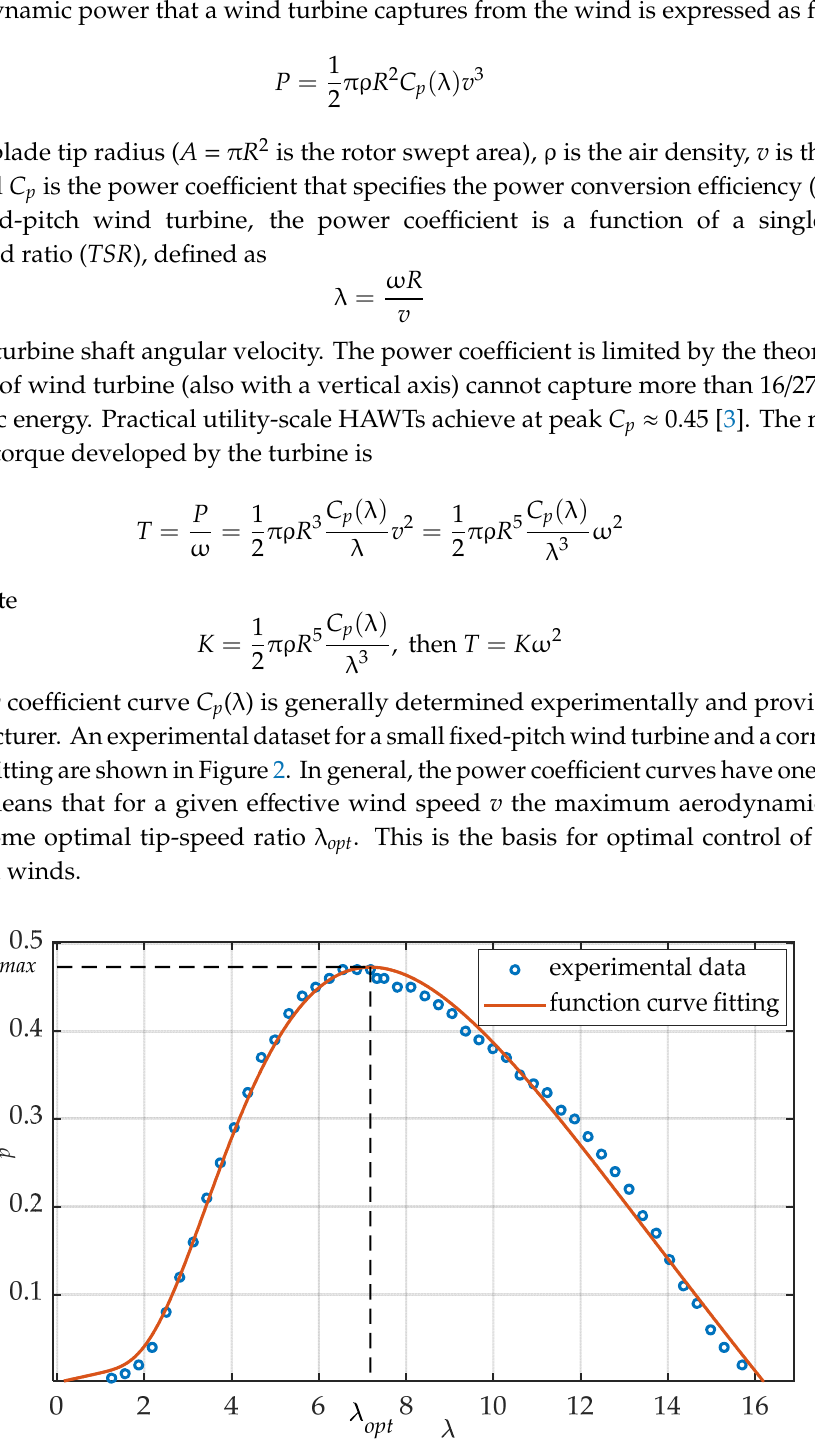
Figure 2. Experimental power coefficient data points and the corresponding function curve fitting using Function (5). Data provided by courtesy of MMB Drives Sp. z o.o., Gda ń sk, Poland.